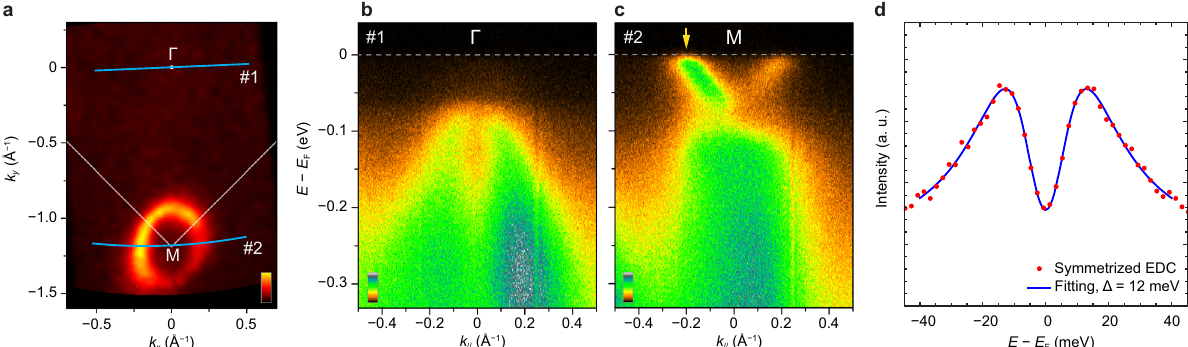
Fig. 4 Angle-resolved photoemission spectroscopy (ARPES) results of 1-UC FeSe/ETO. a Constant energy map at the Fermi energy covering Γ and one of the M points of the Brillouin zone. The gray line indicates the fi rst Brillouin zone boundary. b and c Photoemission-intensity images along cut #1 and cut #2 in panel a , respectively. d Symmetrized energy distribution curve (EDC) taken at the Fermi momentum near M point, marked by the arrow in panel c. The blue line is a fi t based on the BCS self-energy function with a gap size of 12